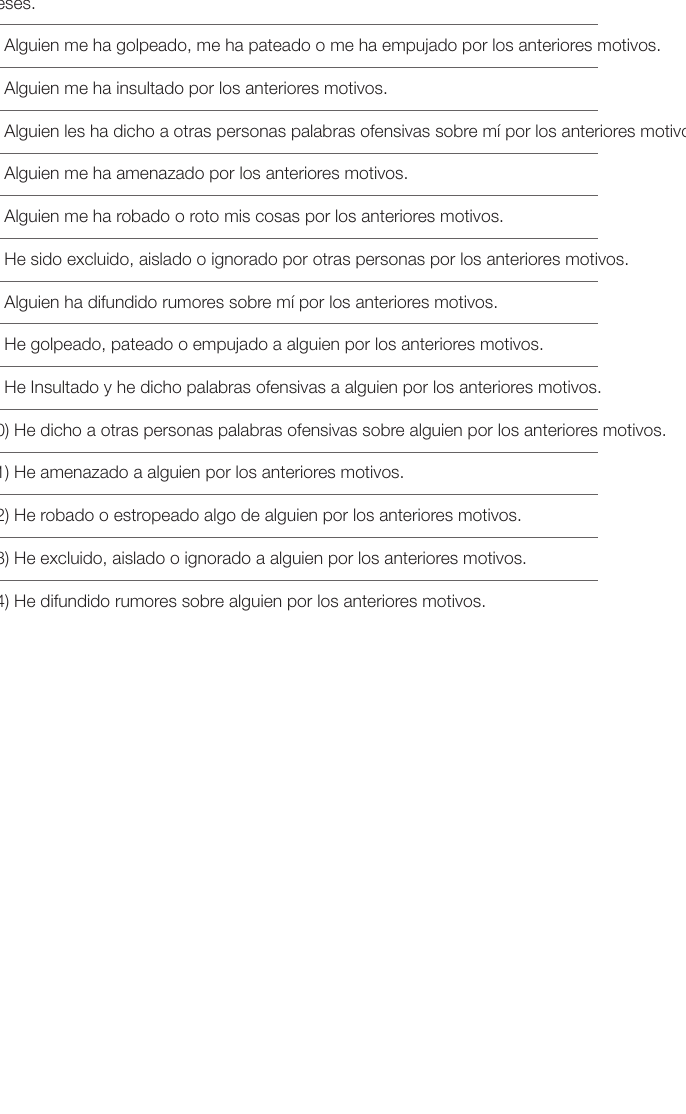
TABLE A1 | Ahora te preguntamos sobre tus posibles experiencias de discriminación en tu entorno (centro escolar, amigos, conocidos), por tu color de piel, por tu país de procedencia, por tu cultura o por tu religión en los últimos dos